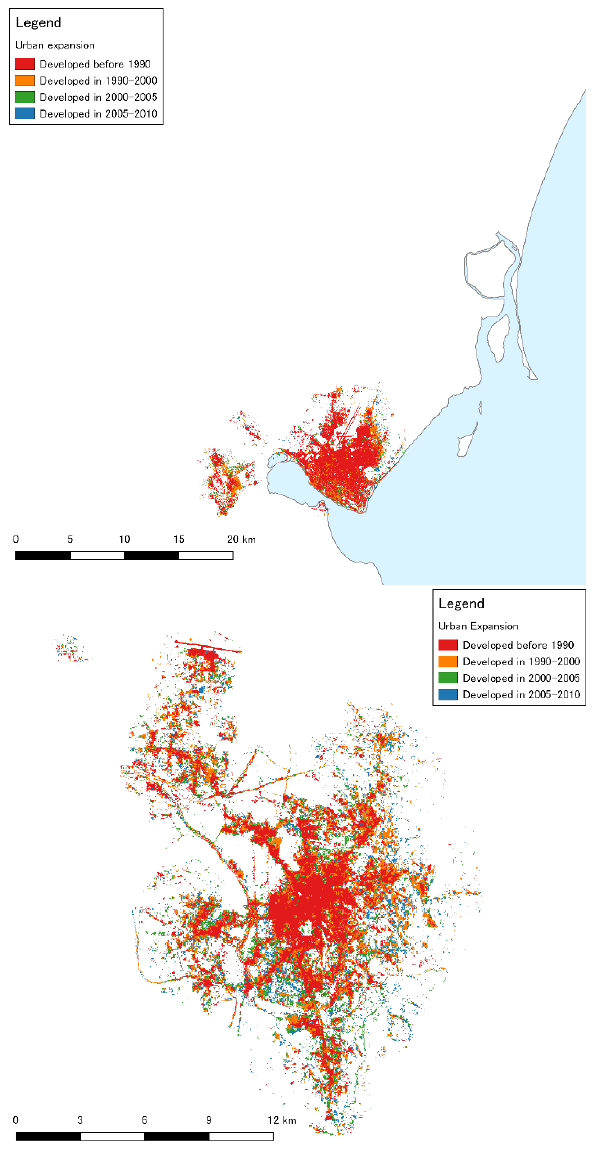
Figure 2. Examples of the results. (a) Maputo, Mozambique; (b) Antananarivo, Madagascar.